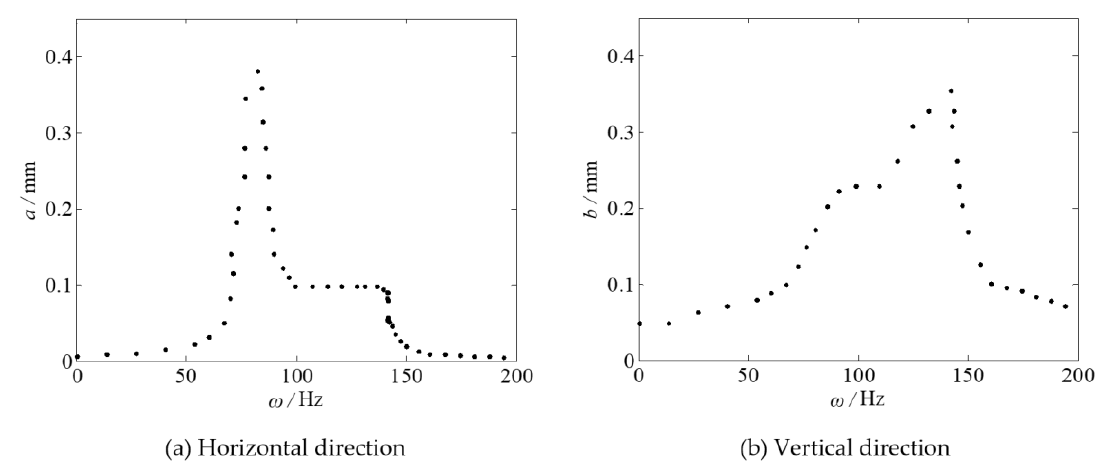
Figure 13. Amplitude–frequency curve of the coupled vibration system of hot rolling mill with gap ∆ x = 0 mm. ( a ) Amplitude–frequency curve of horizontal direction; ( b ) Amplitude–frequency curve of vertical direction.